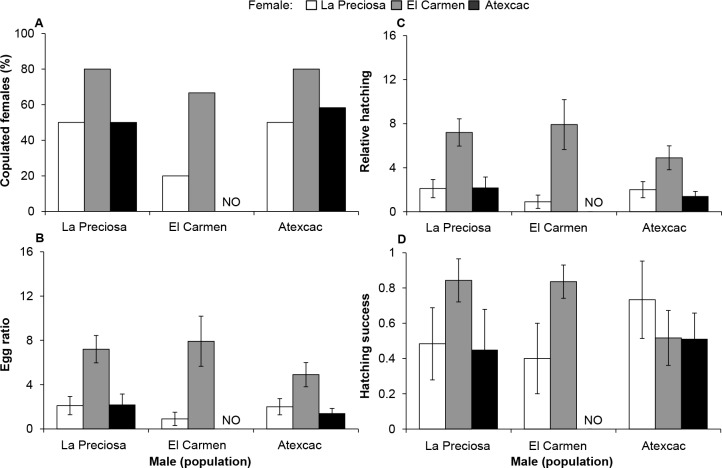
Reproductive compatibility among populations in a common garden experiment (3.8 g L-1).(A) Percentage of copulated females (spermatophore attached to the genital pore). (B) Egg ratio (number of eggs/number of females); (C) Relative hatching (number of nauplii/number of females); (D) Hatching success (nauplii/eggs). Values are mean ± SE.